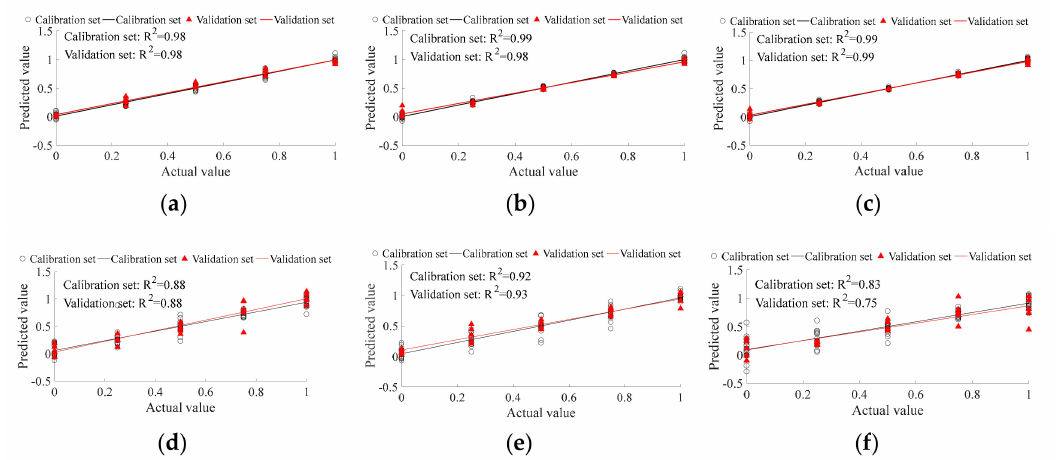
Figure 8. PLSR for ancient Pu’er tea discrimination based on E-nose. ( a – c ) are traditional feature extraction; ( d – f ) are CNN feature extraction; ( a , d ) are E-nose detection; ( b , e ) are VIS / NIR spectrometer detection; and, ( c , f ) are multi-information fusion